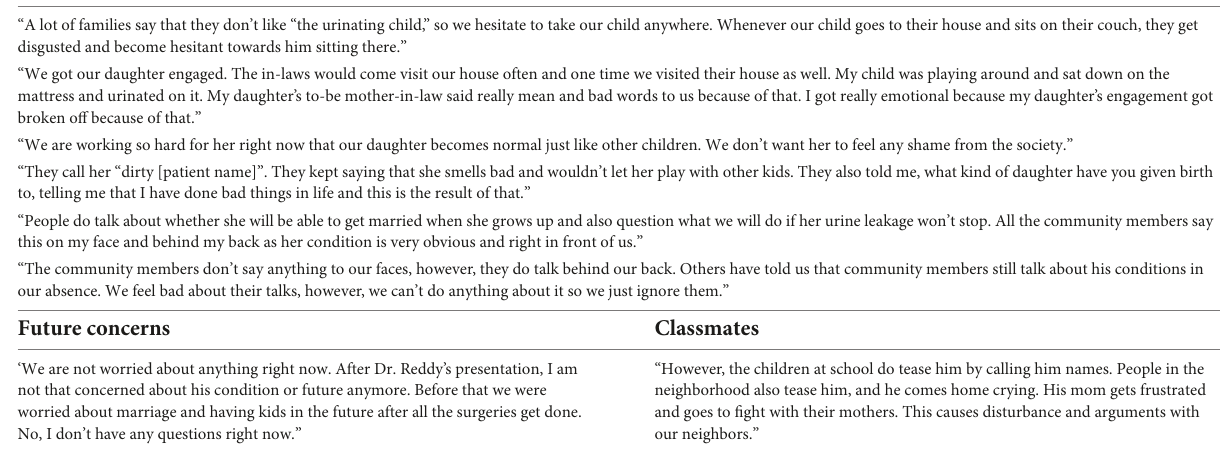
TABLE 2 Illustrative quotes from patients and